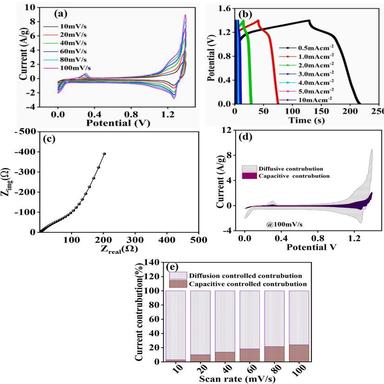
Electrochemical performance of asymmetric device NCO-25 (a) Cyclic voltammetry at different scan rates (10–100 mVs− 1), (b) Galvanostatic chargedischarge at different current densities (1–10 mAcm− 2), (c) Nyquist plot at 10 mV potential, (d,e) Diffusion controlled and capacitive controlled current contribution.